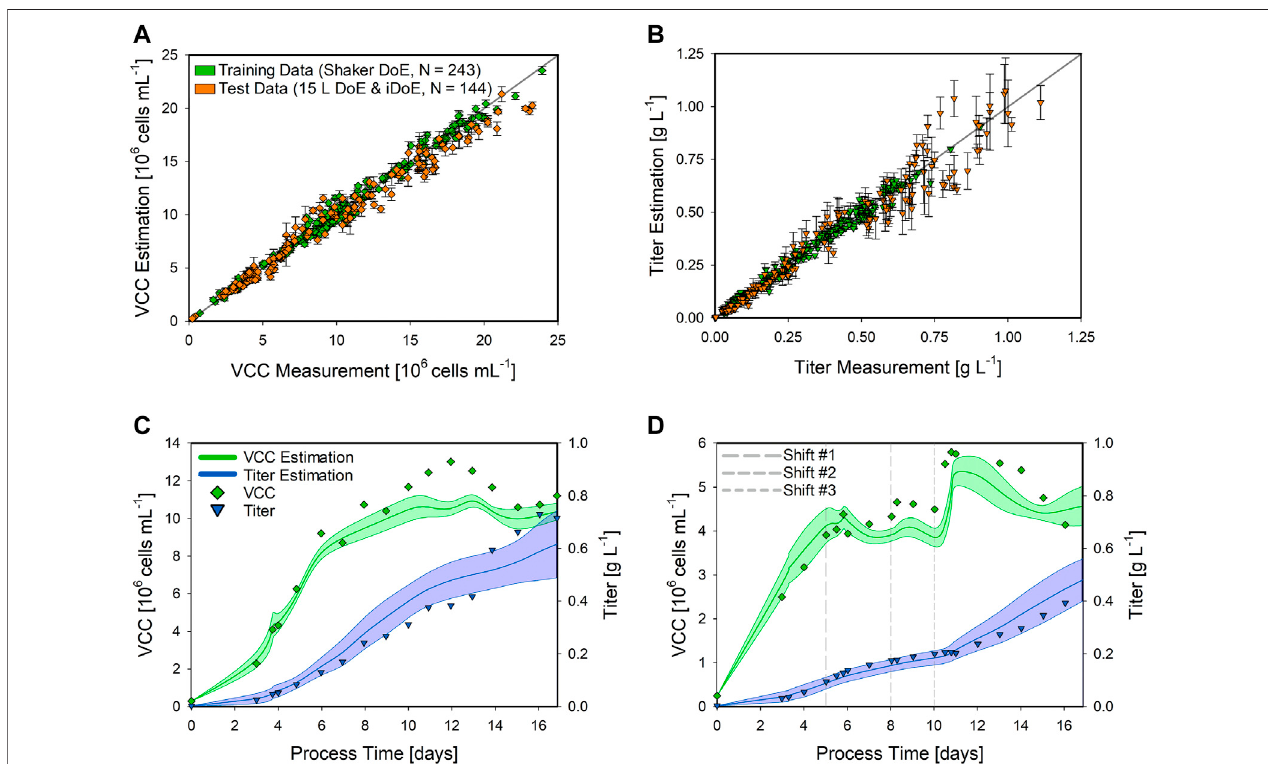
FIGURE 4 | Performance of the shaker hybrid model estimating the VCC and product titer of 15 L bioprocesses. The scatter plots of the hybrid model on the training data (green) and the test data (orange) for the VCC (A) and the product titer (B) are presented along with the standard deviation as error bars. Detailed time- resolved model estimations are presented for a static DoE (C) and an iDoE bioprocess (D) . The model estimations for the VCC (green lines) and product titer (blue lines) are indicated along with the respective CI (shaded area). The analytical measurements are given for the VCC (green squares) and the product titer (blue triangles). For the iDoE bioprocess, the time point of the CPP shifts is indicated (dashed grey lines).